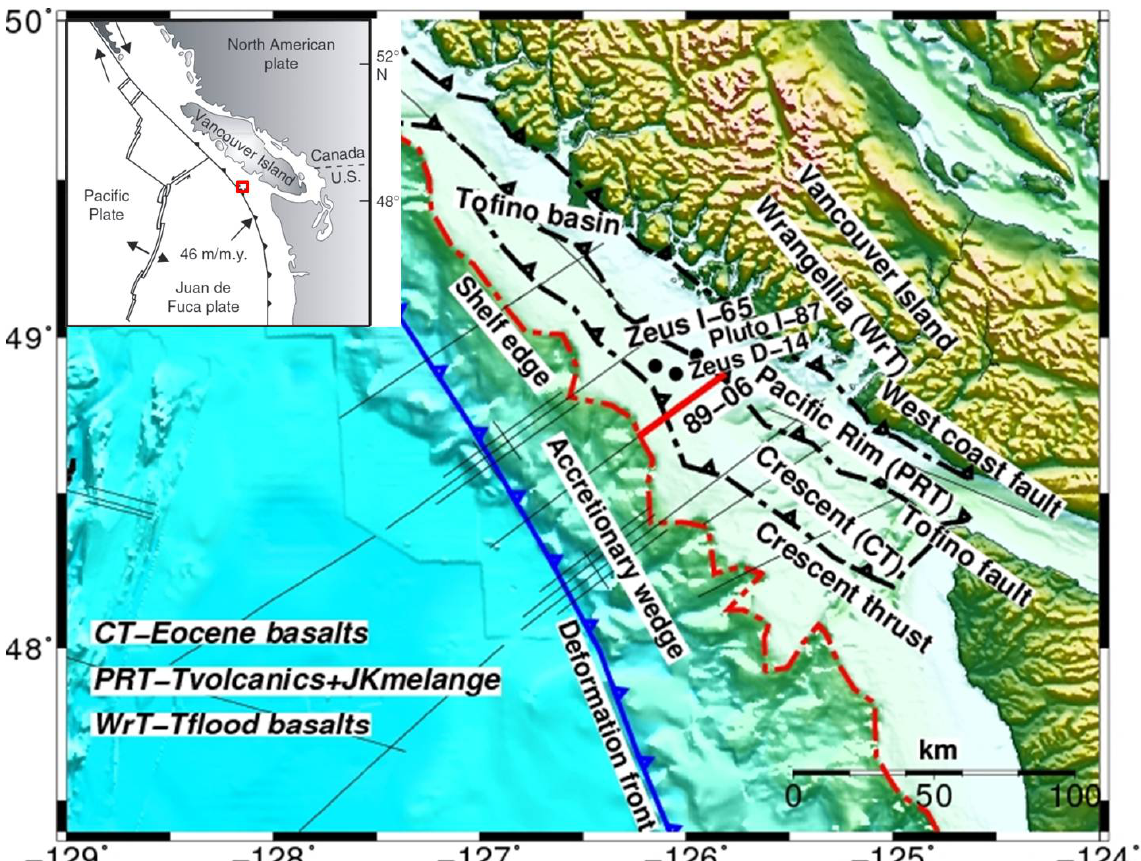
Figure 1. Location of the Tofino basin; dashed red line is the seaward margin of the basin. Thick solid red line indicates the location of multi-channel seismic (MCS) reflection profile 89-06 used in the present study. Black lines indicate the location of other MCS lines on this margin. Black dash-dot lines indicate the surface location of landward dipping Westcoast fault, Tofino fault and Crescent thrust. Inset shows the tectonic setting. Solid circles- well locations; PRT-Pacific Rim terrane; CT-Crescent terrane